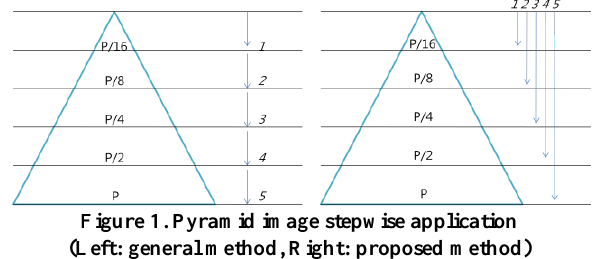
Figure 1. Pyramid image stepwise application (Left: general method, Right: proposed method) While setting the left and right image patches for